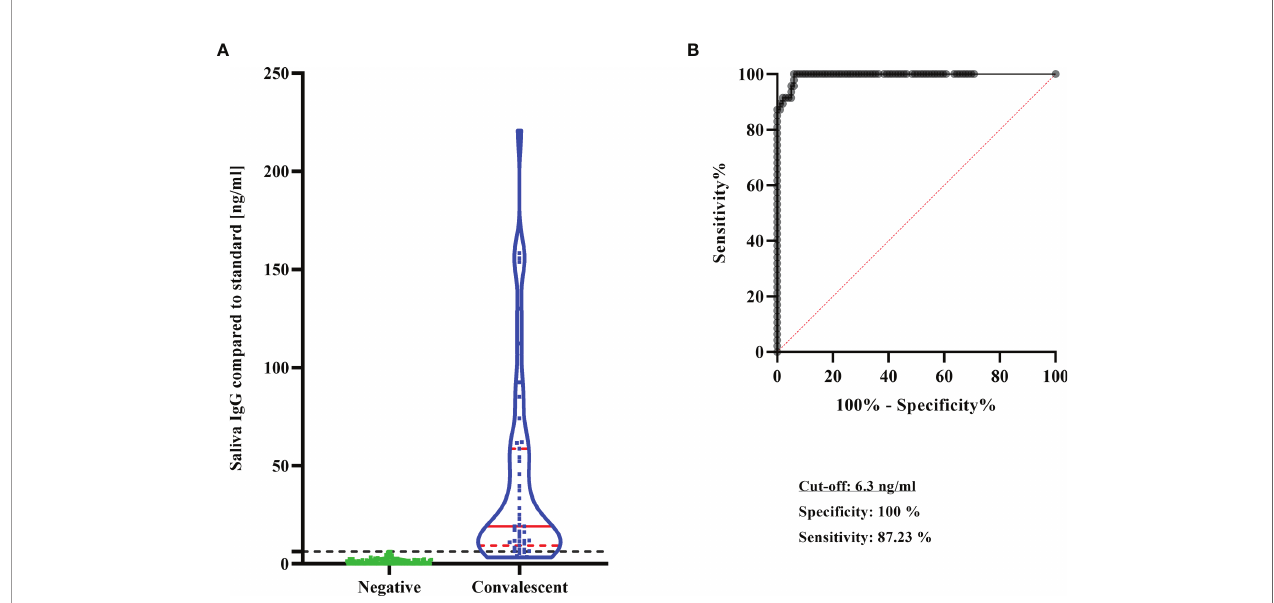
FIGURE 2 | Performance of the saliva ELISA. (A) SARS-CoV-2 IgG concentrations in saliva in the negative group (n = 99) and in the convalescent group (n = 47). Results are shown as violin plots. Solid red lines: median; dashed red lines: quartiles, Dashed black line: cut-off of SARS-CoV-2 IgG positivity. (B) ROC curve analysis to determine diagnostic test performance of saliva ELISA.